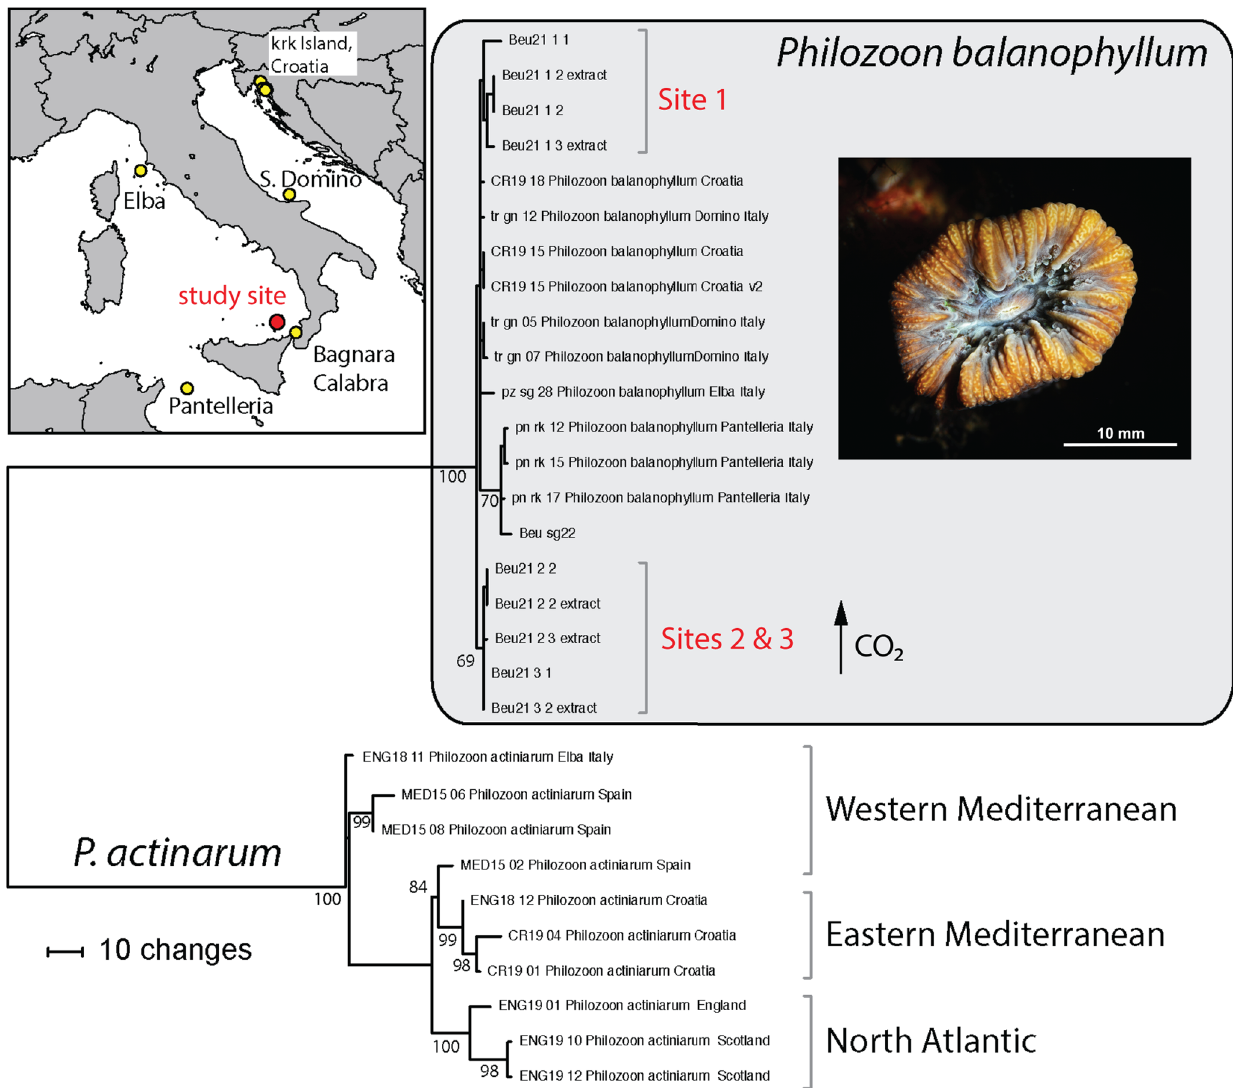
Fig. 5 Philozoon balanophyllum phylogeny. Philozoon balanophyllum halpotypes in B. europaea specimens from Sites 1-3 along the Panarea pH gradient and from around the Tyrrhenian and Adriatic Seas. Haplotypes of Philozoon actinarum , the symbiont of the sea anemone Anemonia viridis , common to the Mediterranean, are provided as the outgroup. (Photograph by Francesco